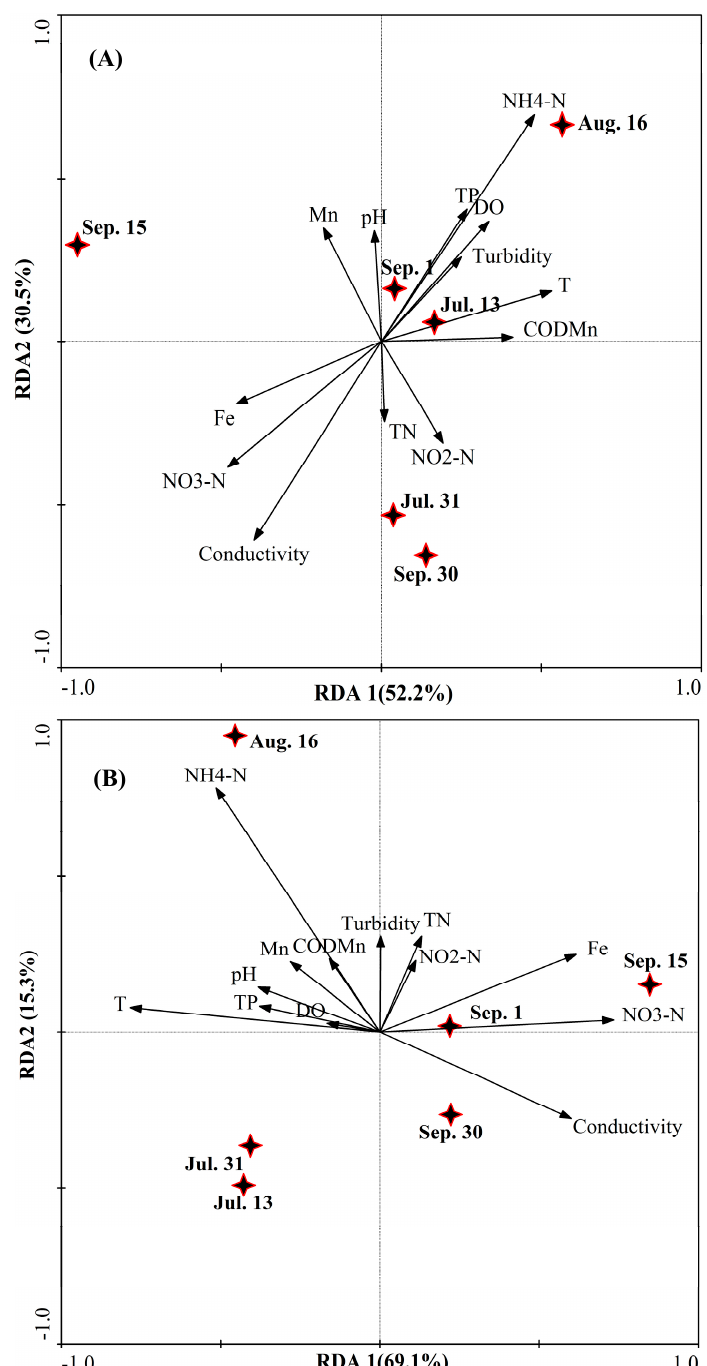
Figure 8. Redundancy analysis (RDA) of water bacterial ( A ) and fungal ( B ) communities in Zhoucun drinking water reservoir during algal bloom outbreak and decline from July to September, 2012. Stars represent sampling points including Jul. 13, Jul. 31, Aug. 16, Sep. 1, Sep. 15, and Sep. 30. For water bacterial community, RDA1 explained 52.2 %, and RDA2 explained 30.5% of the total variance. For water fungal community, RDA1 explained 69.1%, and RDA2 explained 15.3% of the total variance. The primary factors for the variables of the water quality data are represented by arrows (DO=dissolved oxygen; TN = total nitrogen; TP=total phosphorus; COD Mn = permanganate index).